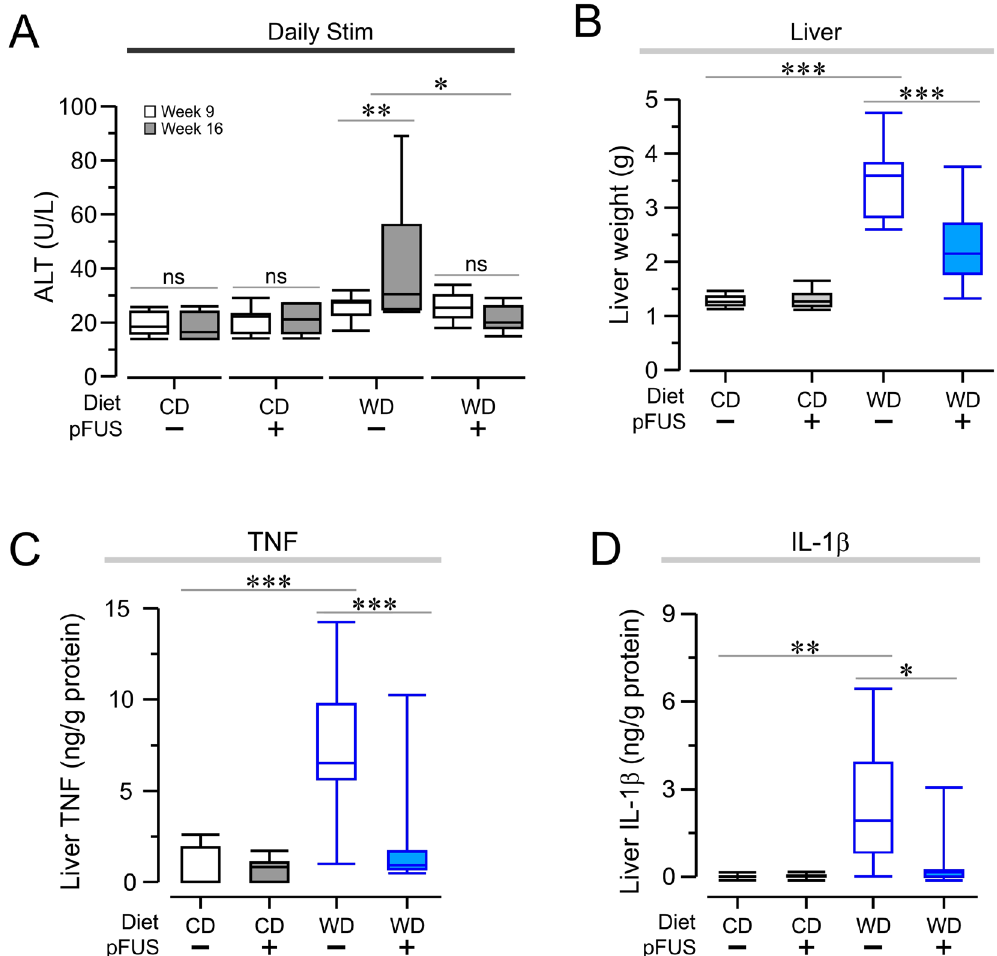
Figure 5. Hepatic pFUS attenuates circulating ALT, reduces gross liver weight, and diminishes proinflammatory cytokines levels. ( A ) pFUS attenuates ALT increase seen in Western diet–sham mice (WD– sham, week 9 vs week 16, ** P < 0.01, two-way ANOVA). pFUS treatment reduces endpoint ALT levels (* P < 0.05, two-way ANOVA). ( B ) Hepatic pFUS reduces liver weight. Western diet–sham mice had significantly increased liver weight compared to control diet–sham mice (*** P < 0.001, one-way ANOVA). Western diet– pFUS mice had significantly lower liver weight compared to Western diet–sham mice (*** P < 0.001, one-way ANOVA). ( C,D ) Hepatic pFUS lowers proinflammatory cytokines in the liver. Wester diet–sham mice had increased TNF levels compared to control diet–sham mice ( C , *** P < 0.001, one-way ANOVA). Hepatic pFUS lowered TNF levels in Western diet-fed mice ( C , *** P < 0.001, one-way ANOVA). Western diet–sham mice had increased IL-1β levels compared to control diet–sham mice ( D , ** P < 0.01, one-way ANOVA). Hepatic pFUS stimulated Western diet-fed animals had lower IL-1β levels ( D , * P < 0.05, one-way